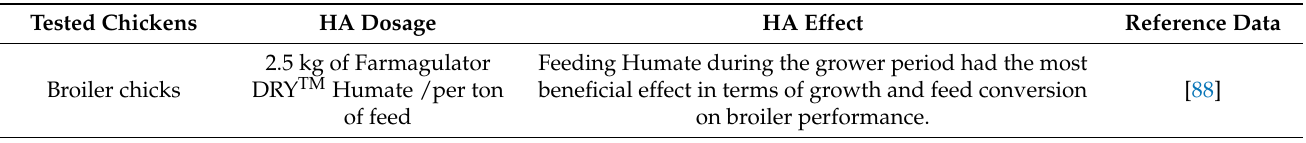
Table 2. The effectiveness of the introduction of humates as a feed supplement in growing broiler